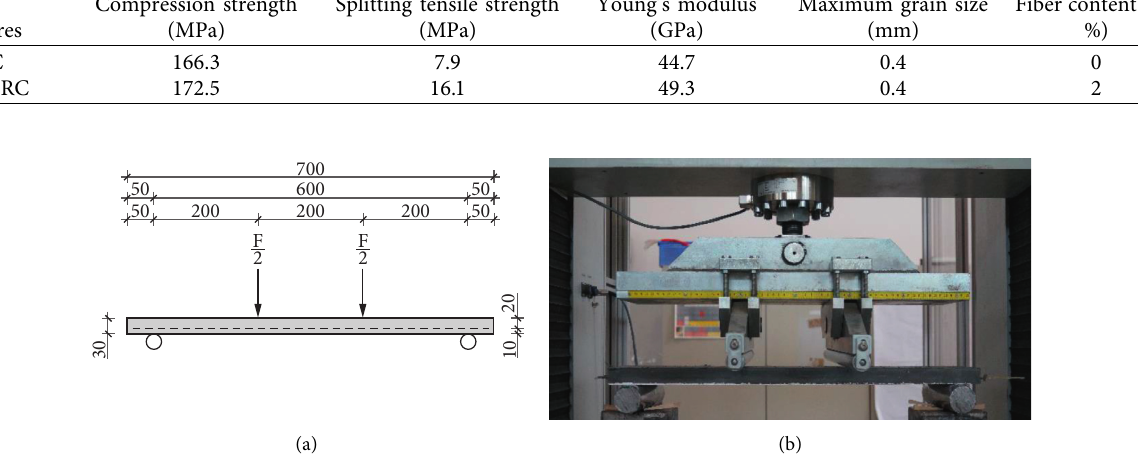
Figure 1: (a) Dimensions of the specimen and the test setup (mm). (b) The test setup during